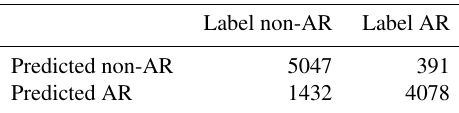
Table 7. Precision and sensitivity scores (described in Sect. 2) cal- culated for all datasets listed in Table 1. Both scores show the ability of the SVM classifier in assigning correct labels to the test